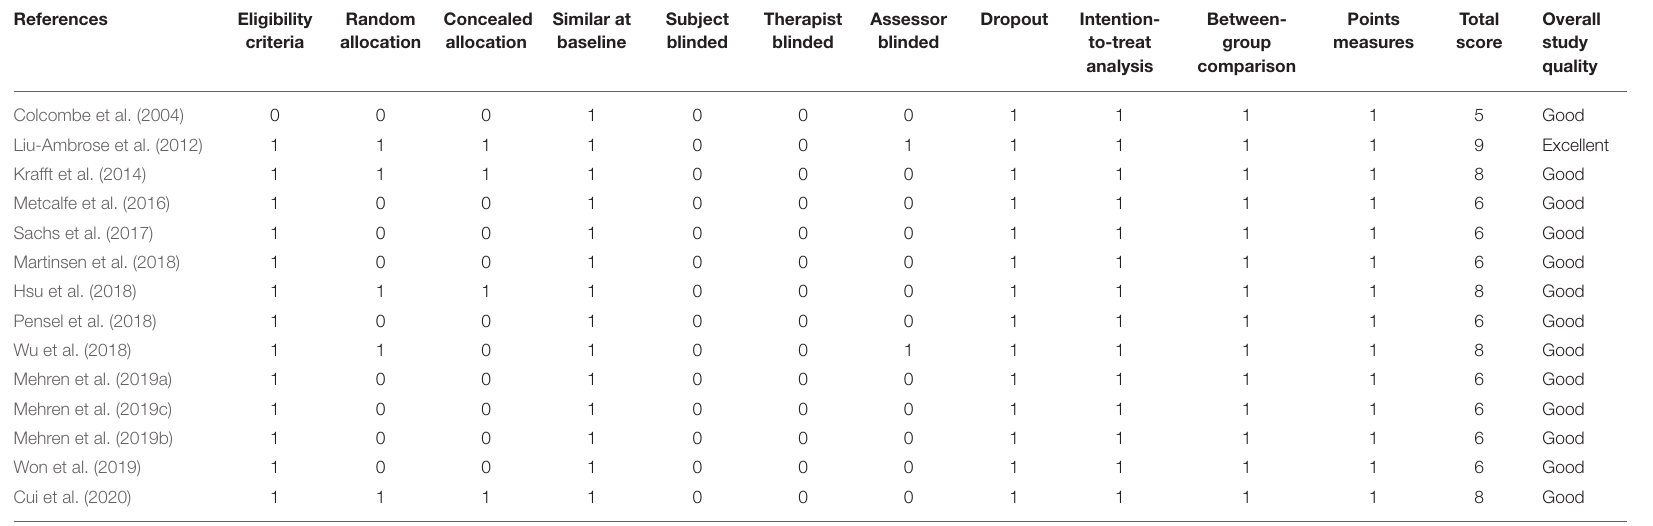
TABLE 2 | Methodological quality assessment of included studies.